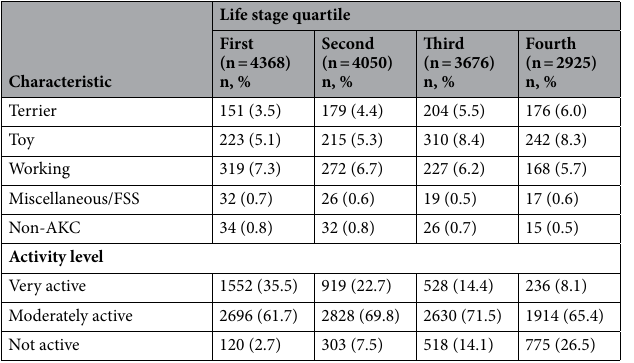
Table 1. Selected canine demographic characteristics by weight-based projected lifespan quartile (n = 15,019), Dog Aging Project